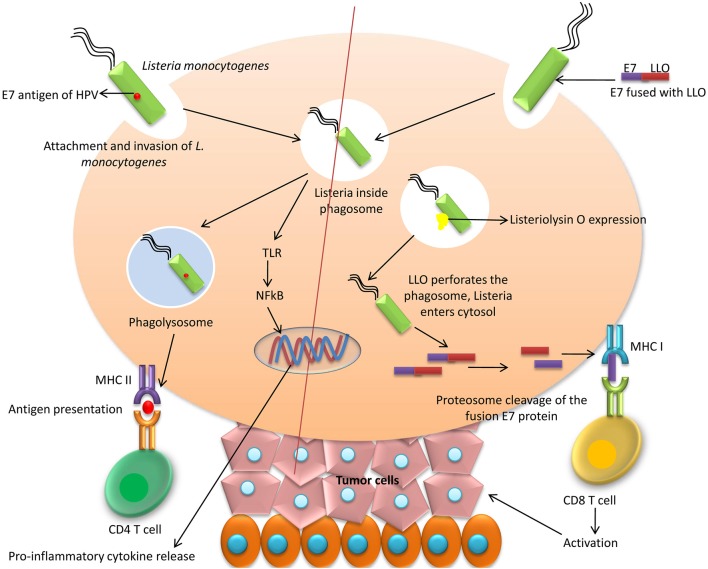
Bacteria-based vaccines. Listeria monocytogenes can be used to secrete HPV E7 which activates CD4 helper T cells through MHC II antigen presentation mechanism. Another method of E7 delivery is to fuse E7 to non-hemolytic listeriolysin O (LLO) protein of the bacteria (Lm-LLO-E7) and thereby on delivery causes perforation of phagolysosome due to LLO and E7 protein made available to MHC I which activates cytotoxic T cells.